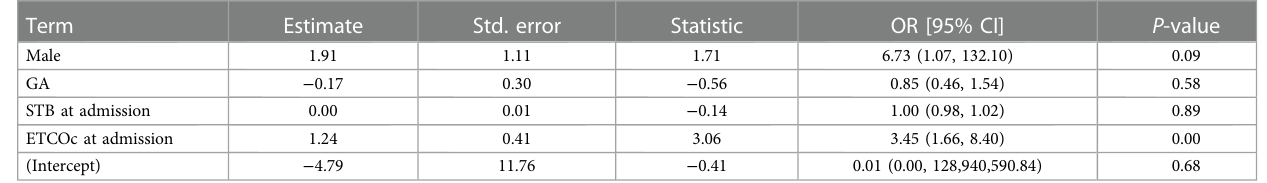
TABLE 2 Multivariate analysis of risk factors associated with the phototherapy duration.